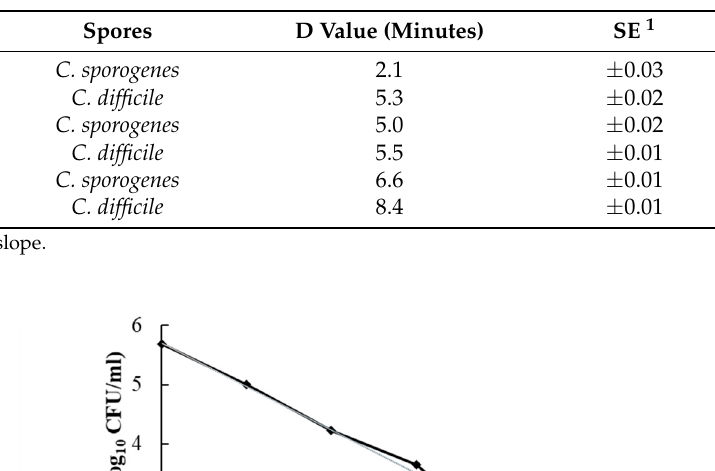
Table 3. Calculated D values for Clostridium sporogenes and Clostridioides difficile spores treated with most effective disinfectants (2, 7 and 10).